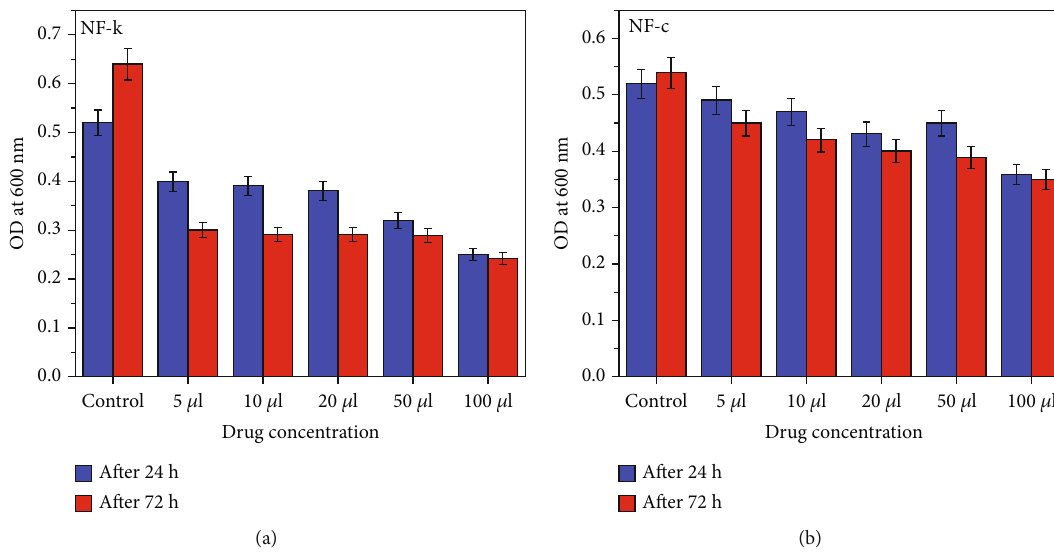
Figure 8: Antibacterial activity of (a) NF-k and (b) NF-c assessed through optical density values.